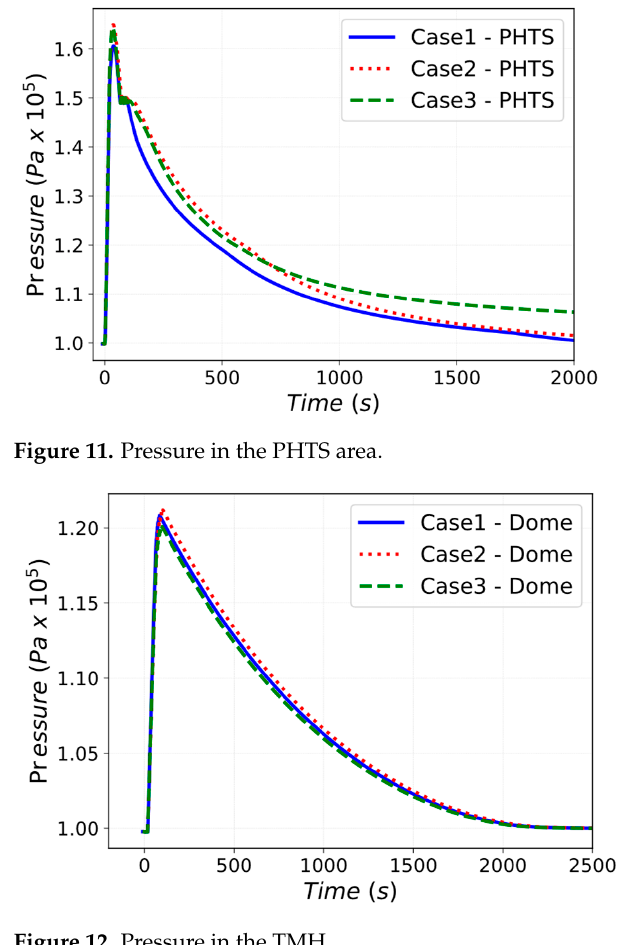
Figure 12. Pressure in the TMH. Table 2. Maximum pressure in the UPC, PHTS area and TMH.